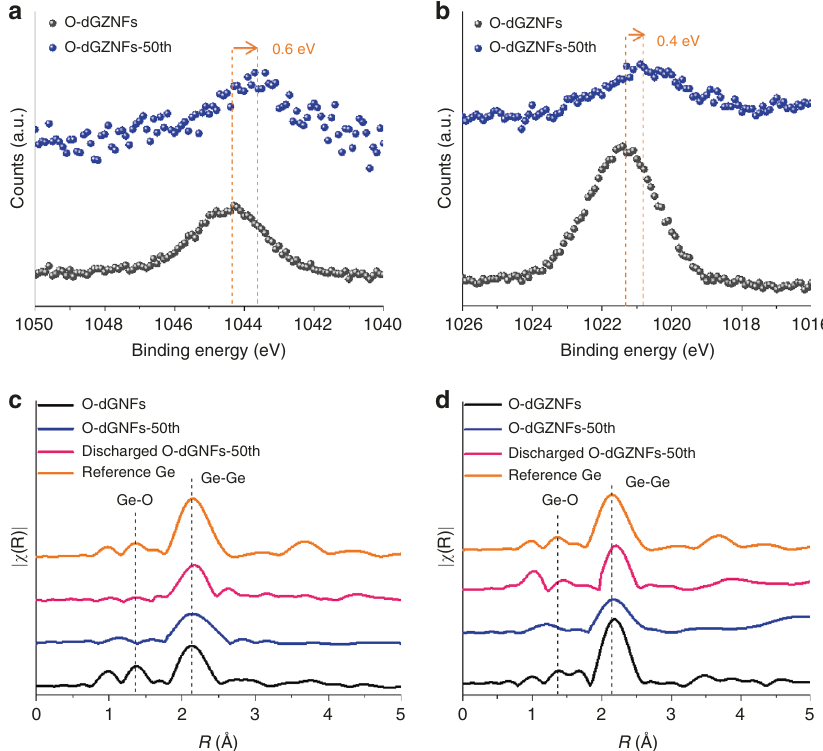
Fig. 4 Physical analysis of O-dGNFs and O-dGZNFs at various states. a , b Core-level XPS spectra of pristine and O-dGZNFs-50th electrodes after partial etching to remove the SEI layer in Zn 2p. EXAFS spectra of c O-dGNFs and d O-dGZNFs at various